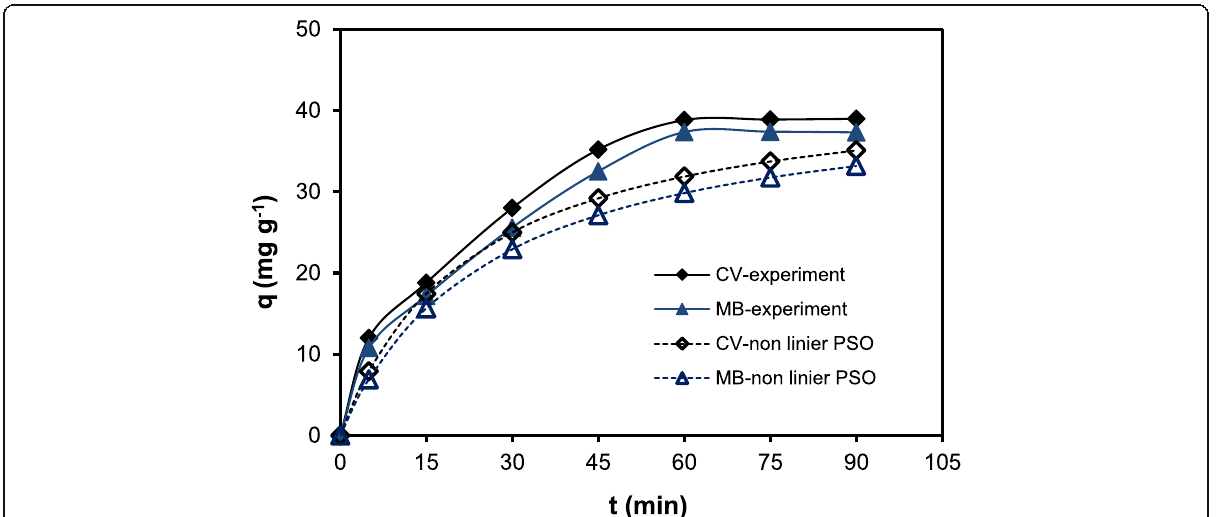
Fig. 5 Experimental data and the fitted non-linear forms of pseudo-second-order (PSO) kinetics models for the adsorption of CV and MB dyes onto ASS (adsorbent dose of 50 mg, volume of adsorbate of 20 mL, pH of 8, and temperature of 27 °C)